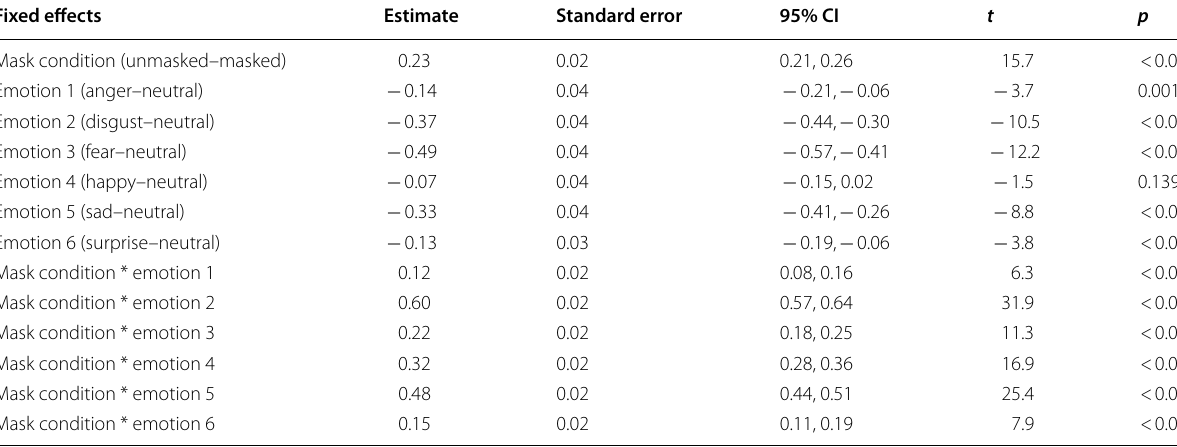
Table 2 Fixed effects table for the mask and emotion linear mixed effects